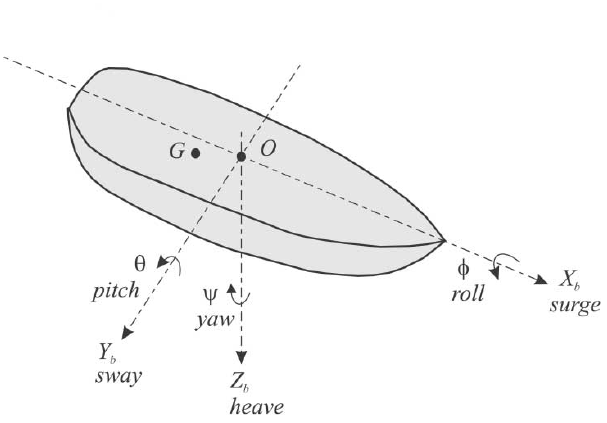
Figure 2. Definitions of ship motions in the b